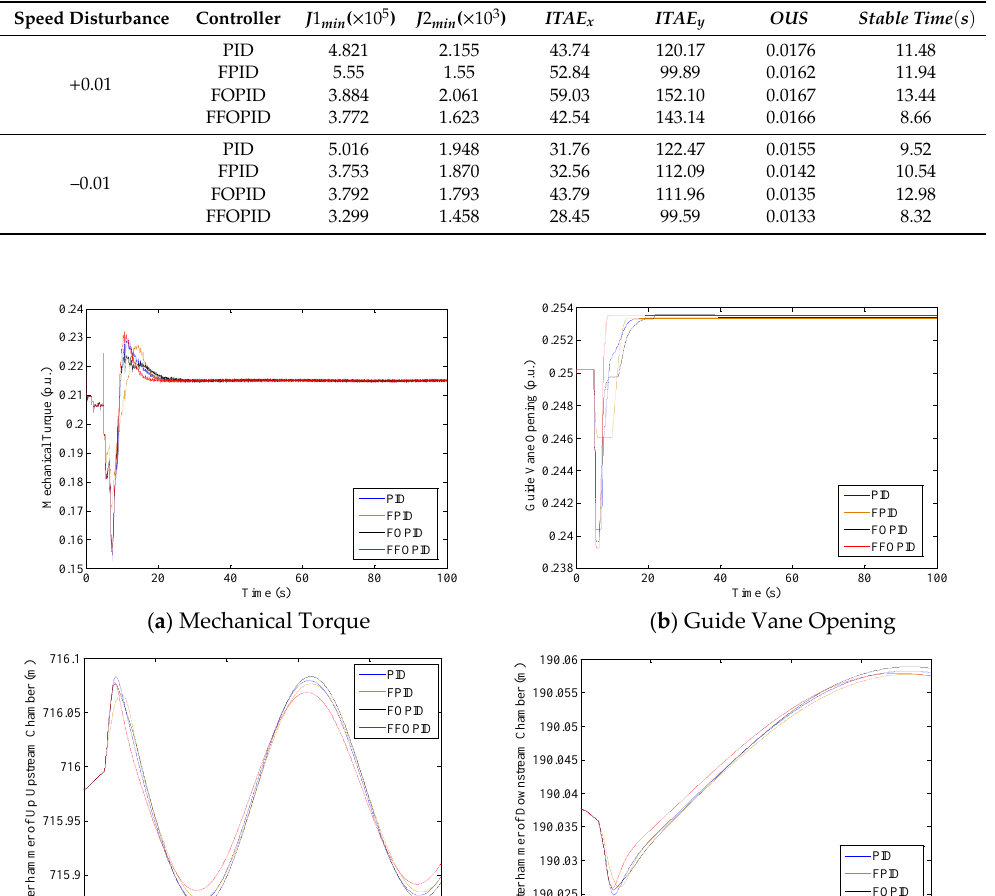
Table 7. Control indices of controllers for pumped storage unit regulating system under rotational speed disturbance.